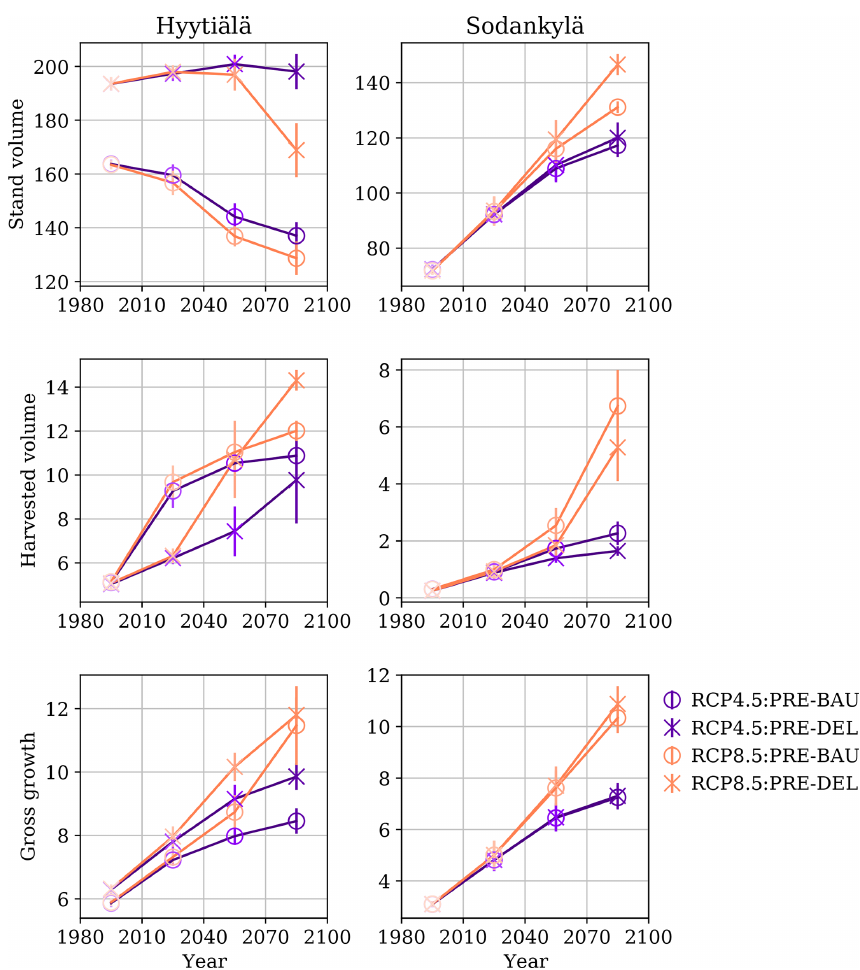
Figure 3. Selected ecosystem indicators from the PREBAS biomass factors, averaged for the 30-year-long periods. The y -axis whiskers at each point represent the point-specific uncertainty: 1 standard deviation amongst the corresponding simulations. We use lighter shading for the earlier periods, a different colour for the RCP scenarios and a different marker to separate the management